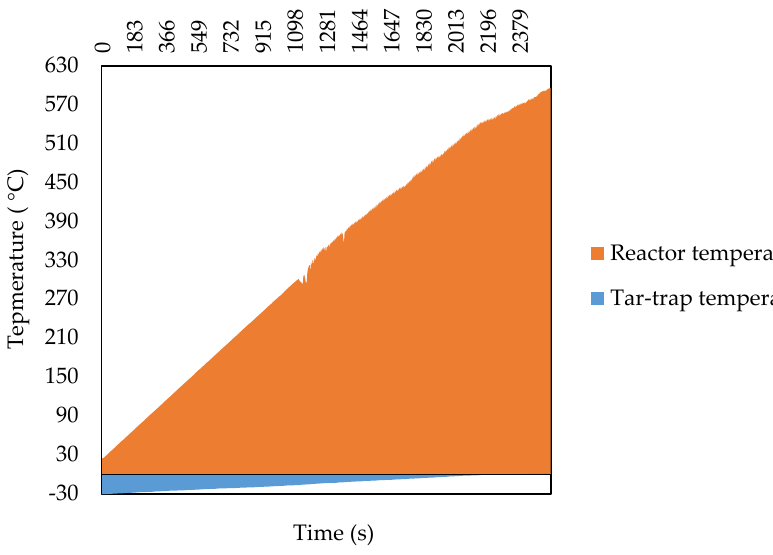
Figure 3. Pyrolysis process and tar trap temperatures versus time of pyrolysis.